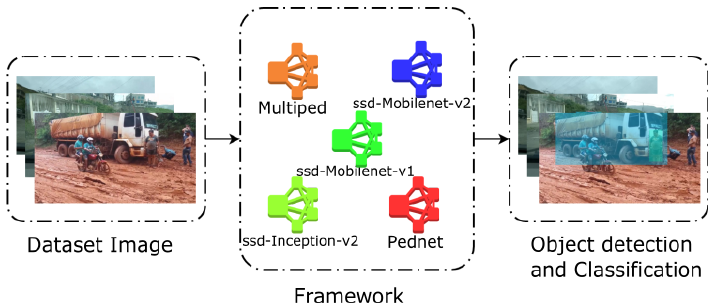
Figure 5. Main steps of the method